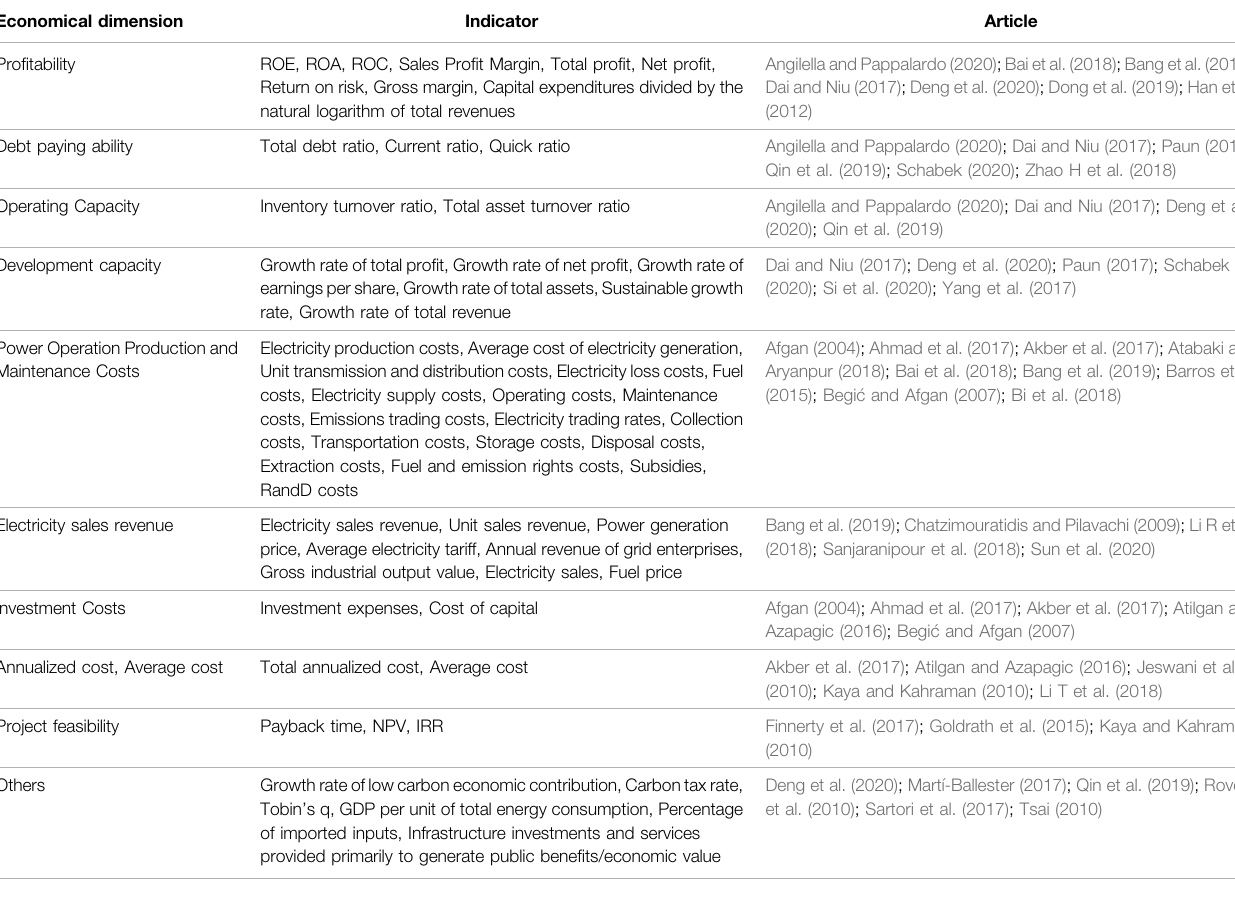
TABLE 8 | Summary of economic sustainability indicators.